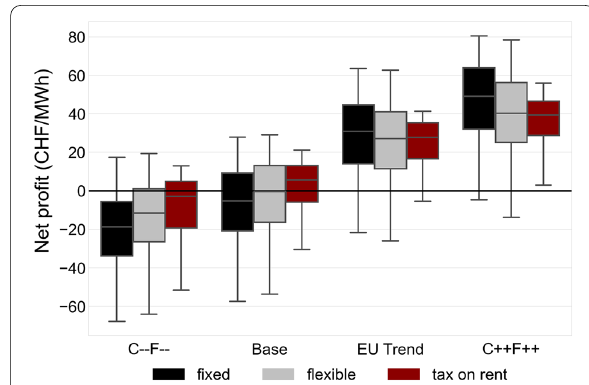
Fig. 4 Boxplots of unit net profits in 2025 for market scenarios and water fee regimes. Note : Boxes include median, 25th and 75th percentiles. Whiskers are defined as 1.5 times the interquartile range. Outliers are not shown. The market revenue for each company for a given market scenario is independent from the water fee regime and differences shown within the scenarios are solely the result of the different water fee regimes